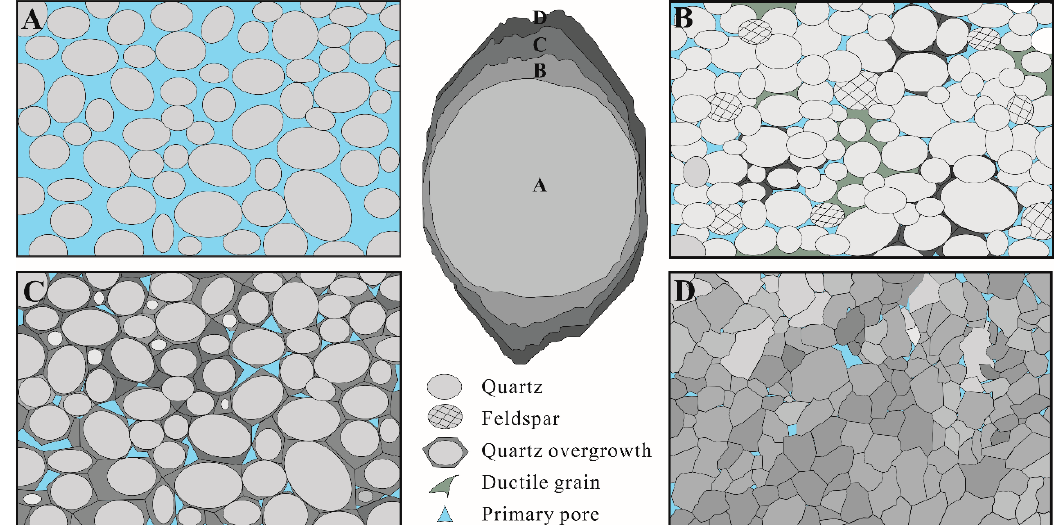
Figure 6. 2D model of evaluation of quartz sandstone reservoir. ( A ) quartz grains before the diagenesis; ( B ) quartz grains developed a layer of micron quartz during early digenetic stage; ( C ) quartz grow to the hexagonal dipyramid grain; ( D ) the dipyramid grain suffered both the cementation and compaction.